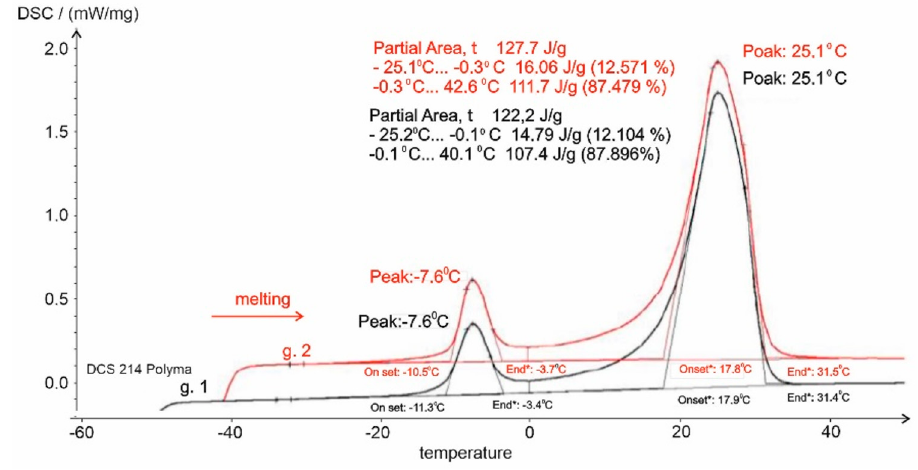
Figure 1. Results of DSC test.